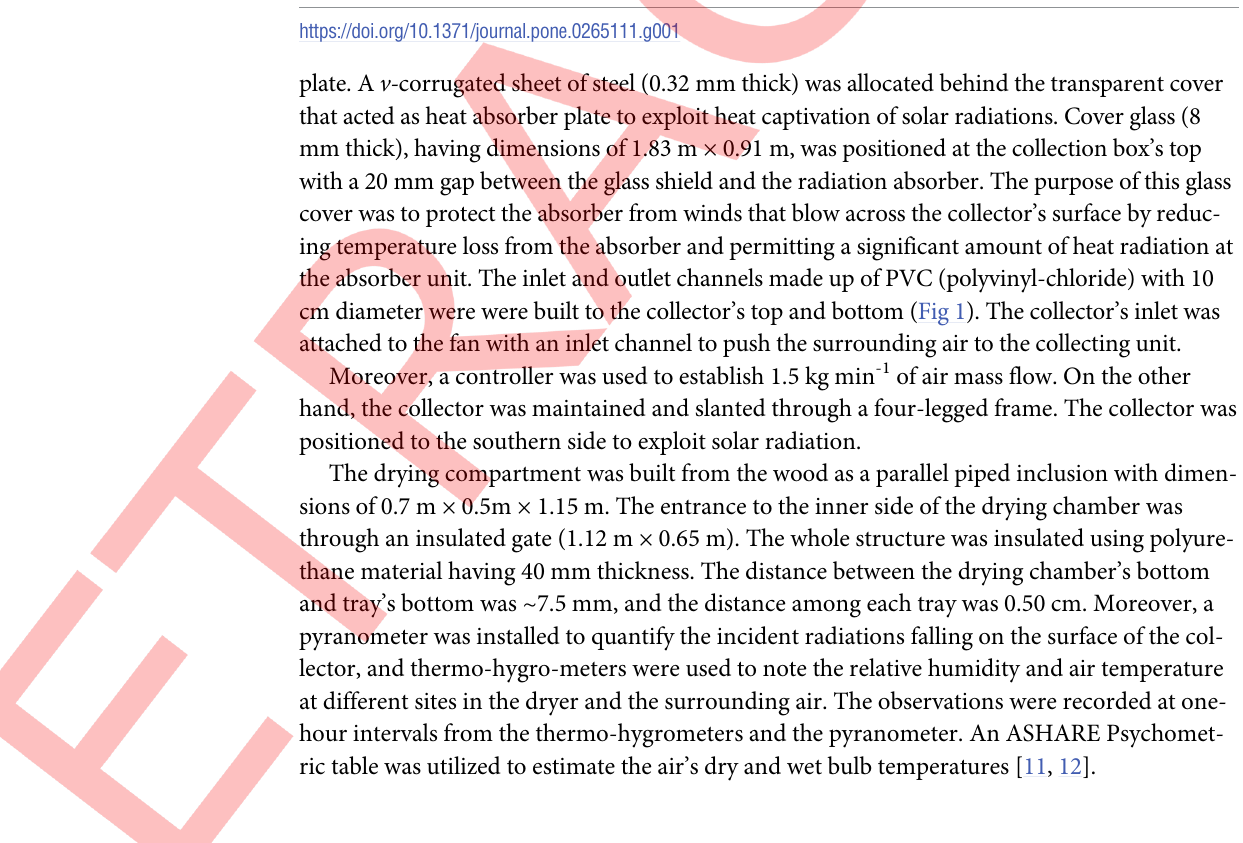
Fig 1. General overview of the solar drier. Fig 1 is excluded from this article’s CC-BY license. See the accompanying retraction notice for more